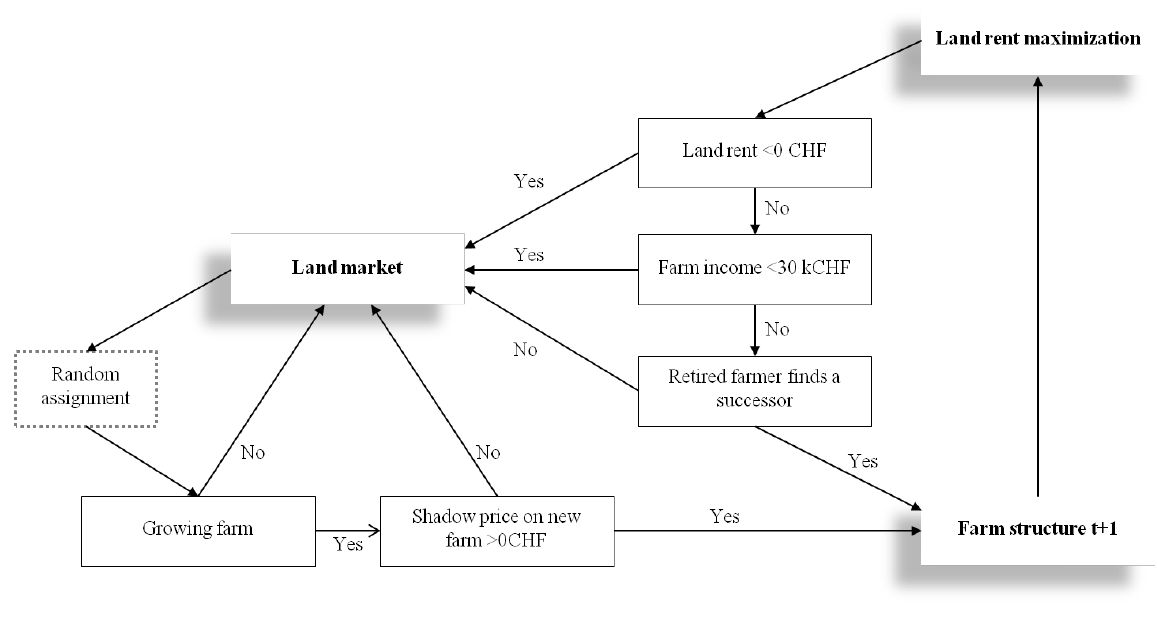
Figure A1 : Process of farm structural change in ALUAM-AB